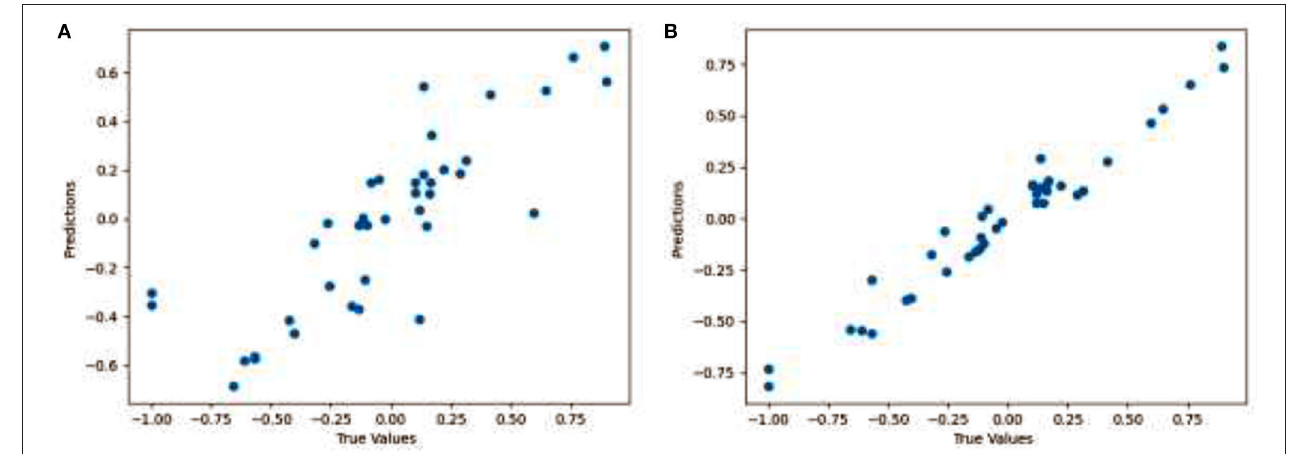
FIGURE 8 | Visualization showing the distance between the ground truth and the predicted gaze for (A) Face + FL and (B) Face + FL + VGG16.